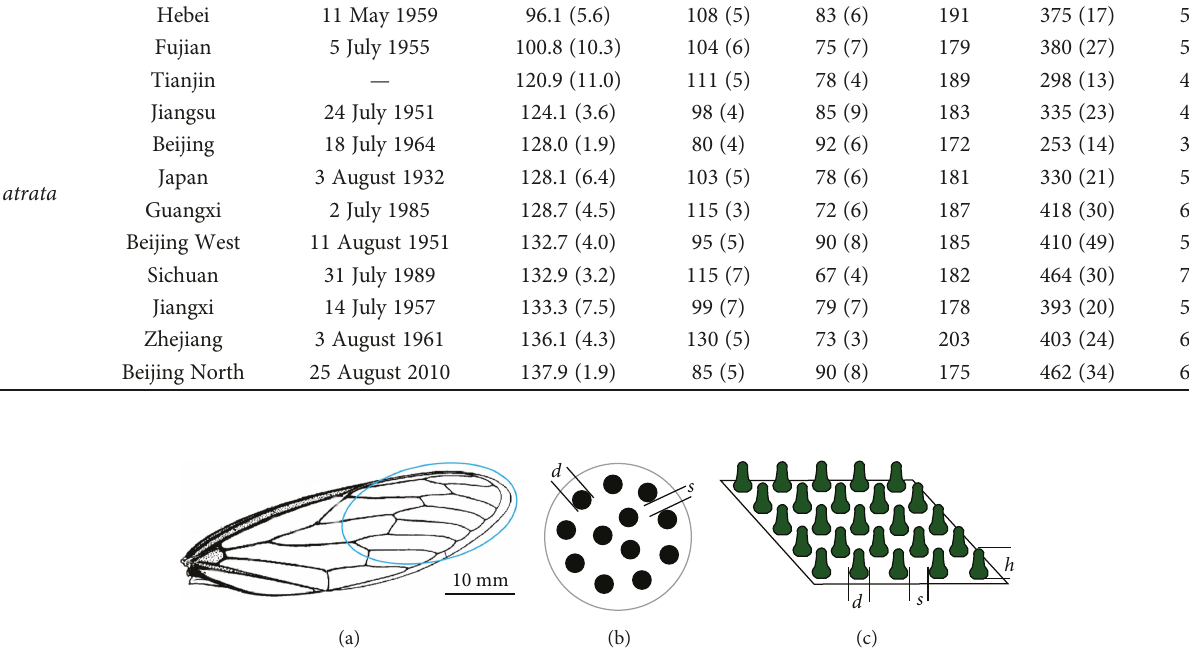
Figure 1: The cicada wing under investigation and the schematic of the wing structures. (a) Image highlighting the test location on the wing (circled). (b, c) Schematic highlighting the dimensional parameters: d , s , and h are the diameter, spacing, and height of protrusions on the cicada wing surface, respectively.